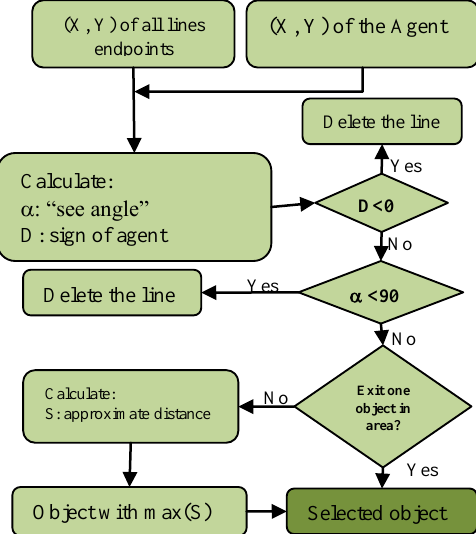
Figure5. The methodology used for object selection